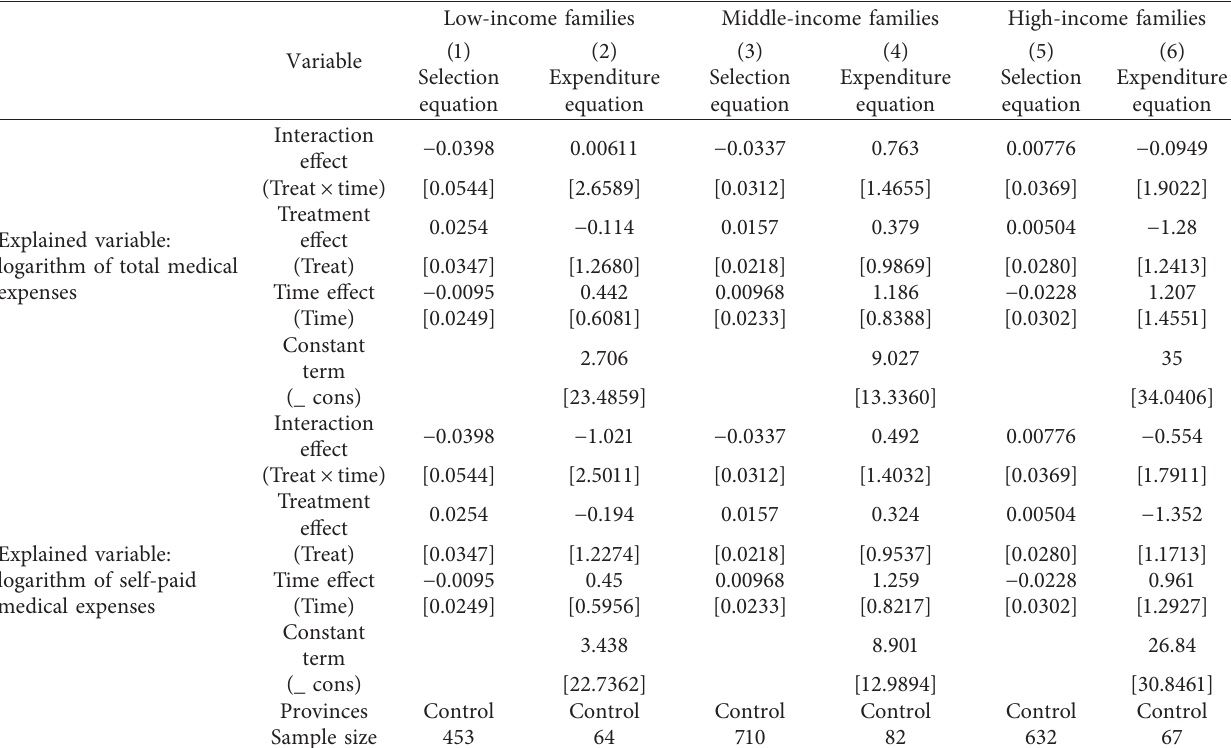
Table 6: Release effect of normal medical needs.